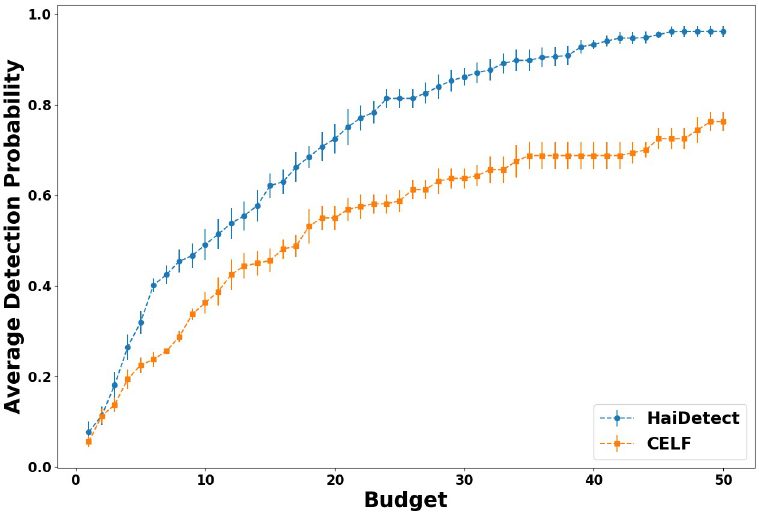
Fig 6. Probability of detecting future outbreaks (normalized) for different budgets. H AI D ETECT significantly outperforms C ELF implying that monitoring sensors selected by H AI D ETECT have higher chance of detecting an